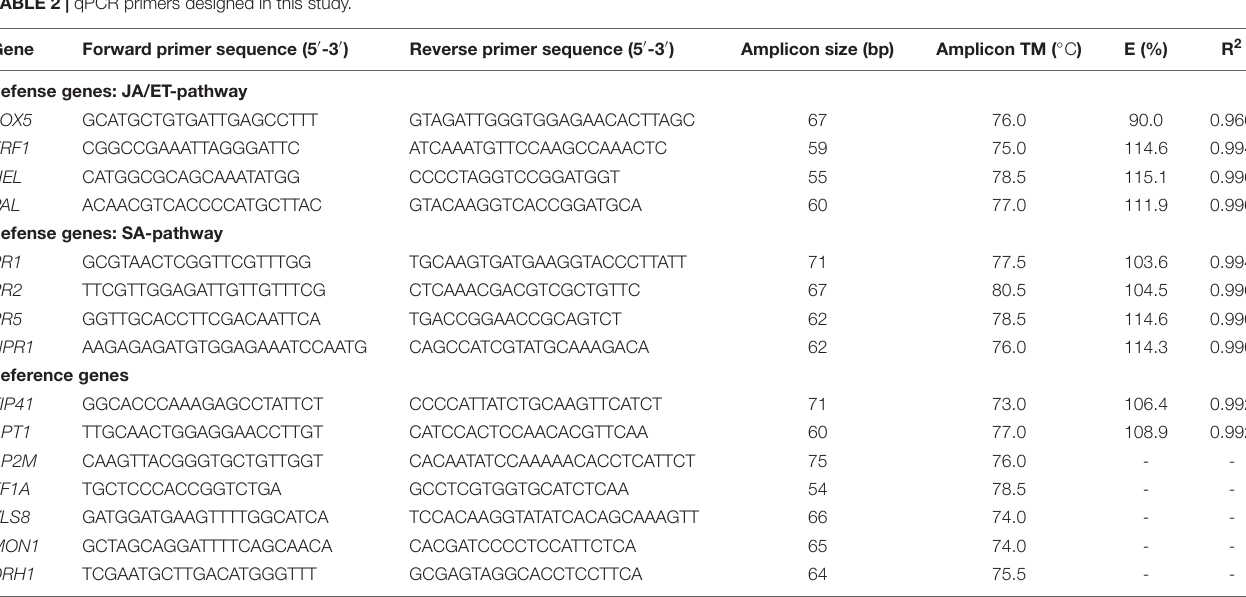
TABLE 2 | qPCR primers designed in this